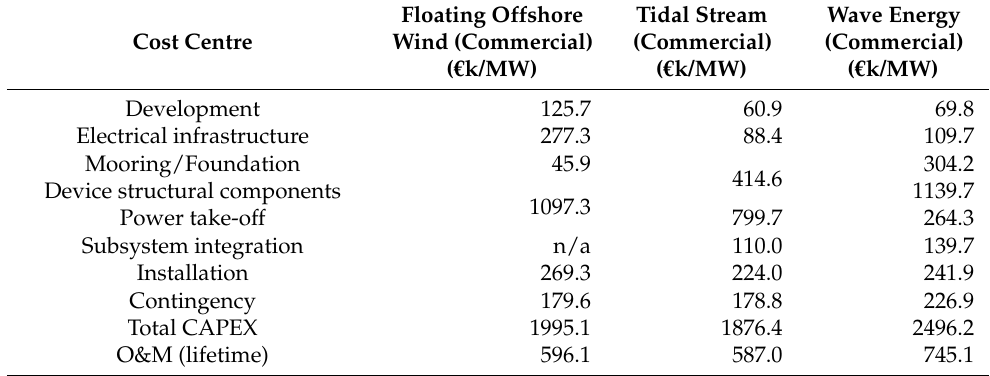
Table 9. Commercial stage target costs per MW for floating offshore wind, tidal stream, and wave Table 10. Early-stage target costs per MW for floating offshore wind, tidal stream and wave energy energy. for the central LR